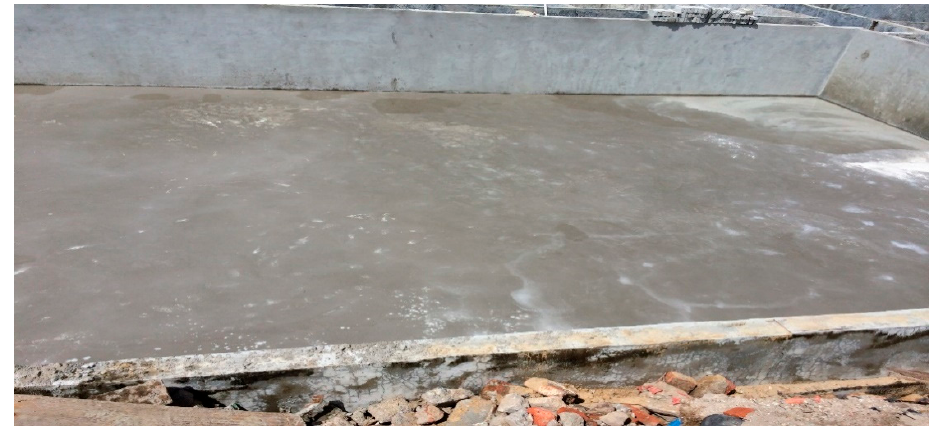
Figure 2. The site of grouting bed.